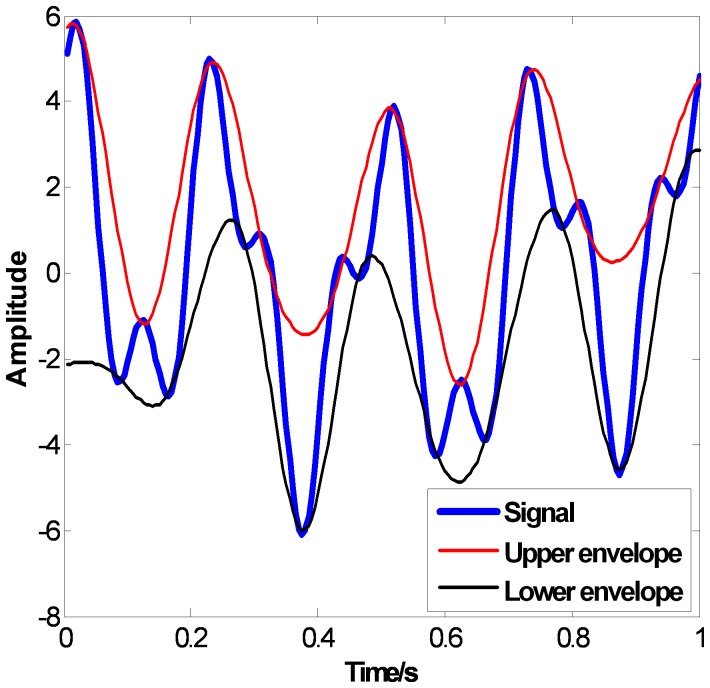
the CSI envelopes.